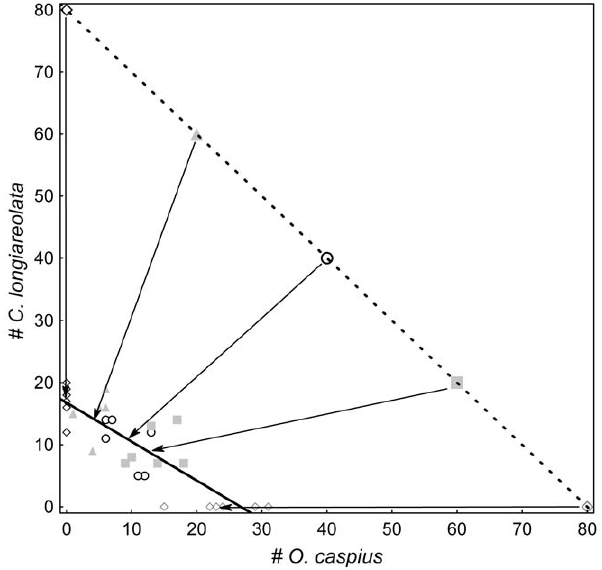
Figure 1. Initial vs. final species abundances. Initial (1 st instar) and final (emerging adults) abundance combinations of O. caspius vs . C. longiareolata in the experimental cups. Initial densities are connected by the dashed line (slope [ 2 1]). The solid line represents the linear regression between the numbers of adults of the two species emerging from the experimental cups (slope 2 0.71). Arrows connect initial larval abundance combinations in the different treatments with the approximated centroid of the final species combinations of adults emerging from the respective experimental cups.